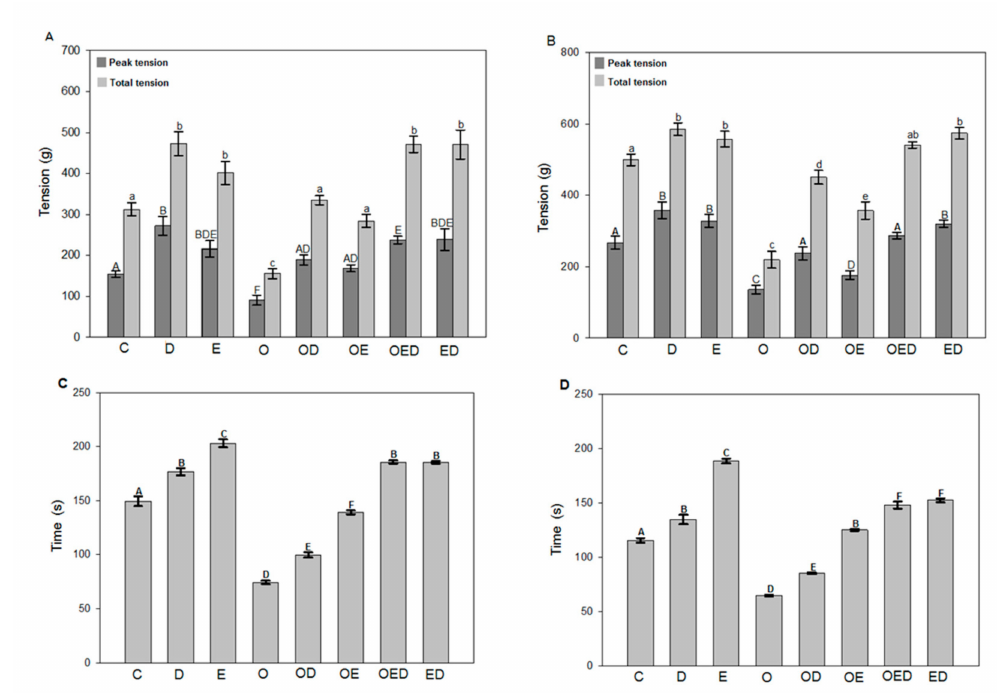
Figure 1. E ff ect of diazoxide and exercise on maximum, total tension, and time of resistance to fatigue of slow and fast skeletal muscle of obese rats. ( A ) Maximum tension and total soleus muscle tension, ( B ) maximum and total tension of the EDL muscle, ( C ) fatigue resistance time for soleus muscle, and ( D ) fatigue resistance time for EDL muscle. C: control; D: diazoxide; E: exercise; O: obese; OD: obese diazoxide; OE: obese exercise; OED: obese diazoxide exercise; ED: diazoxide